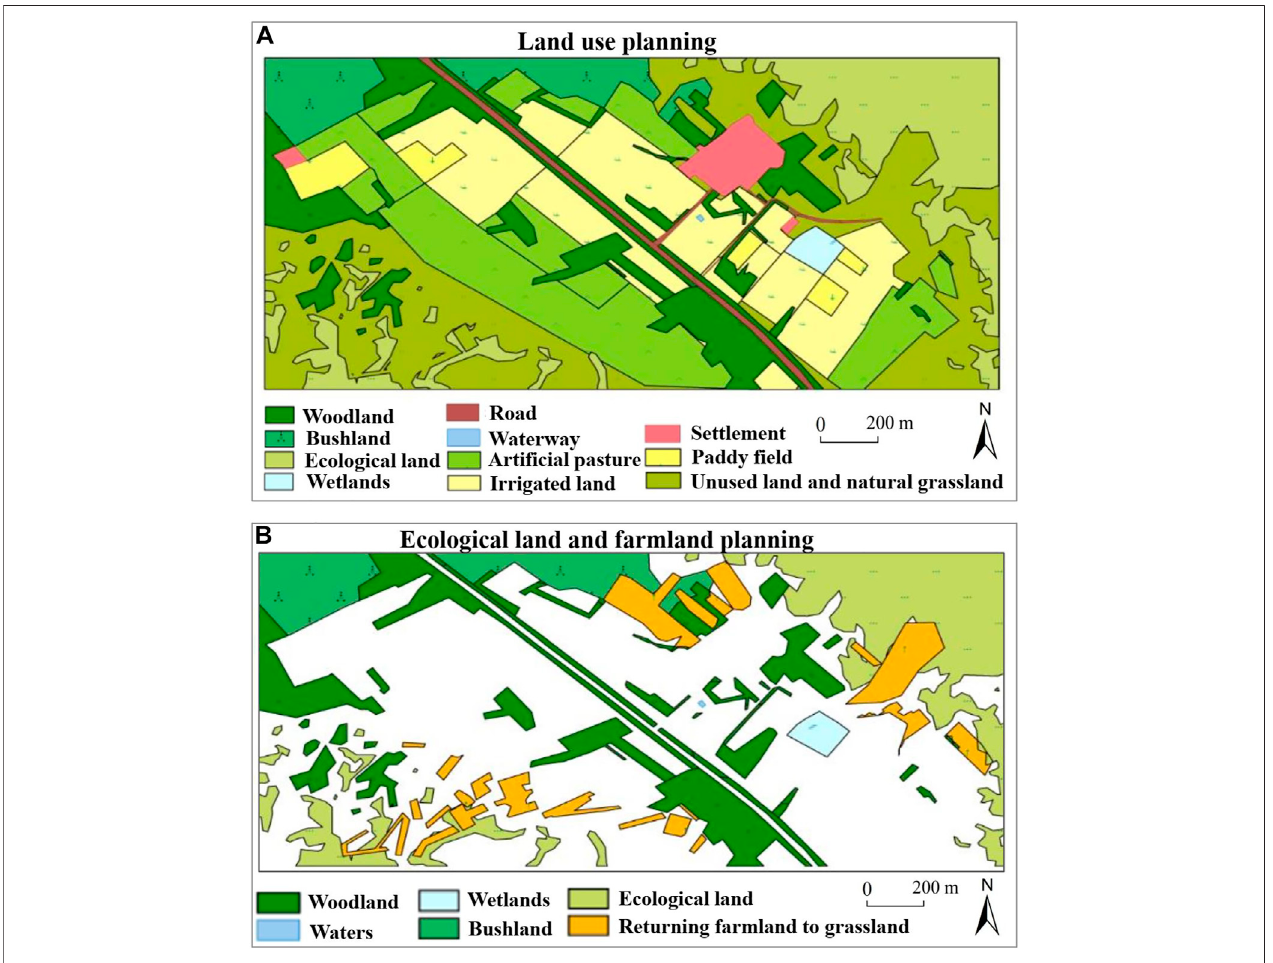
FIGURE 5 | Land use planning, ecological land and farmland planning.